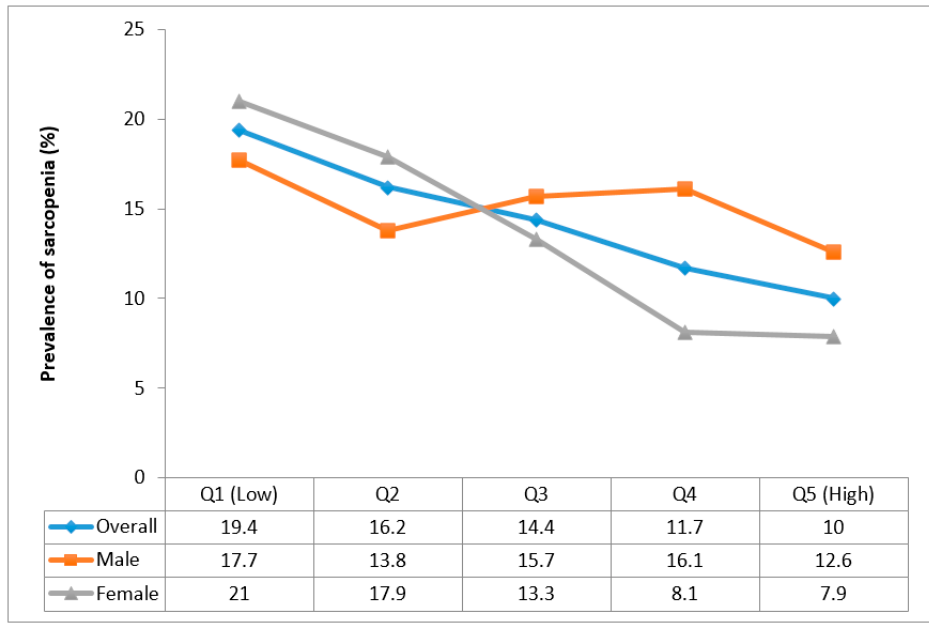
Figure 1. Prevalence of sarcopenia by quintiles of fruit consumption.